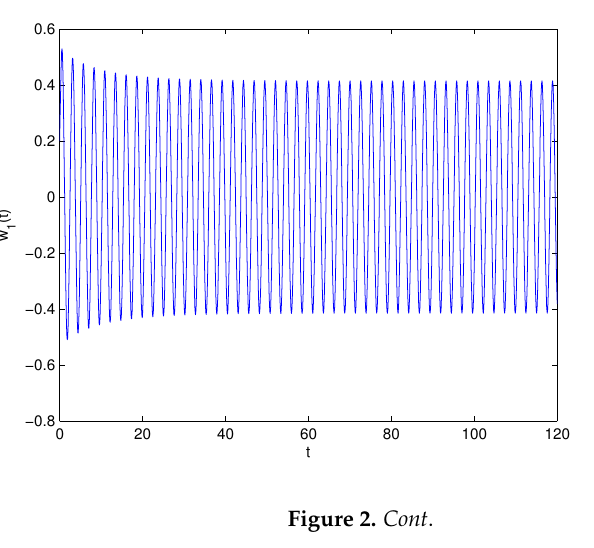
Figure 1. Matlab simulation outcomes for system (71) when ϑ = 0.35 < ϑ 0 = 0.37. The null equilibrium point E ( 0,0,0,0,0 ) of system (71) keeps locally asymptotic stability.